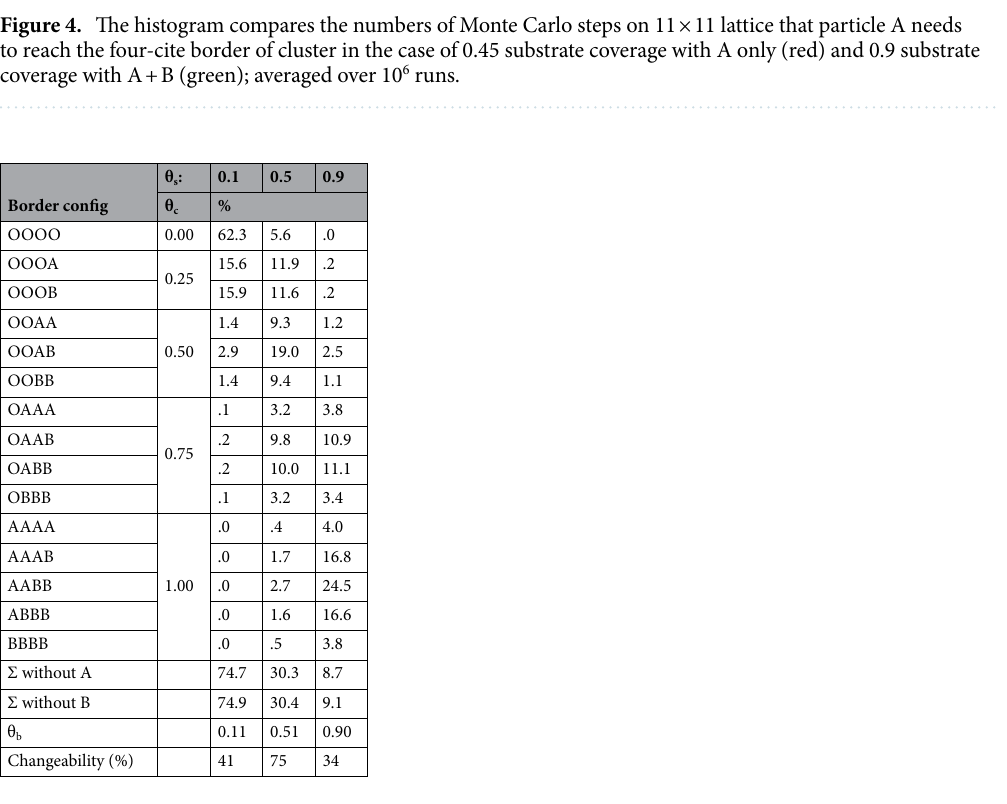
Table 3. Results of the kinetic Monte Carlo simulations of the surface diffusion on 11 × 11 lattice; started with certain coverage of the substrate with A + B (1:1) and free four-cite border, continued during 10 6 runs; θ s is the substrate coverage, θ c is the coverage corresponding to particular configuration, configuration means specific filling of the border with adsorbate (all possible configurations are included), θ b is the averaged coverage of the border, "Σ without A" is the total percentage of configurations without A, Changeability is the percentage of MCS at which the configuration is